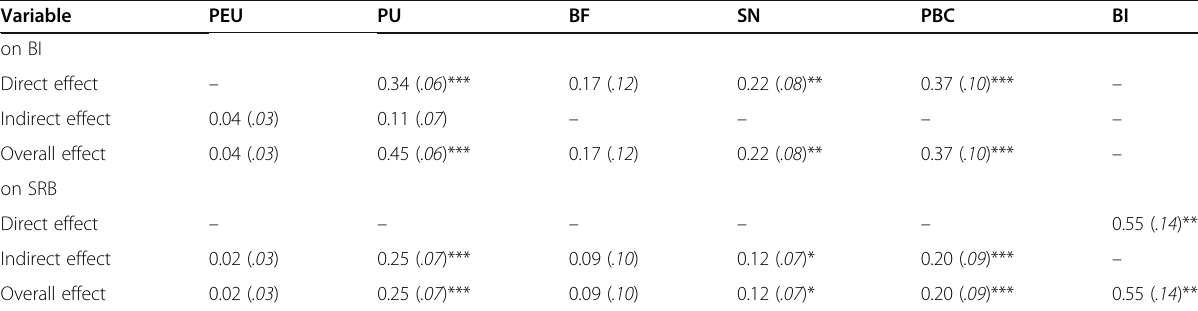
Table 5 Direct, indirect, and overall effects of the latent variables on BI and SRB